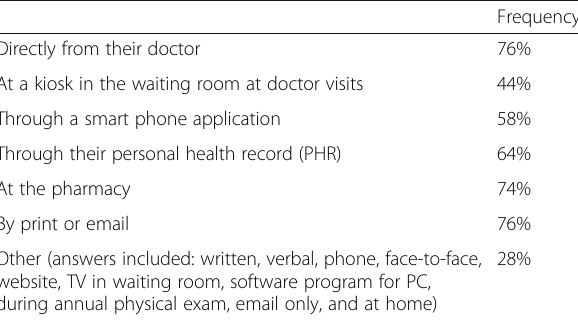
Table 5 Participant answers to multiple choice question about preferred methods to receive interaction alerts ( N =